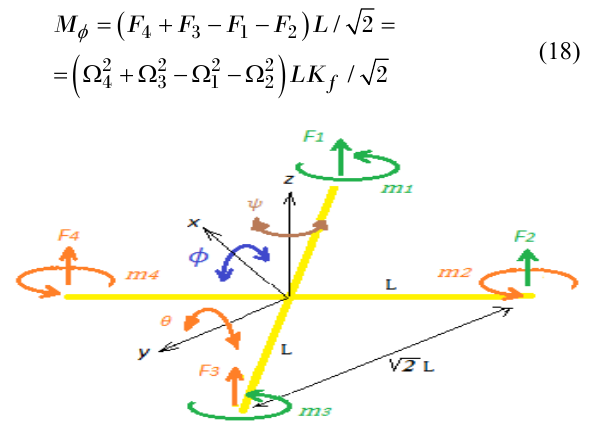
Figure 5. Cross-quadcopter general